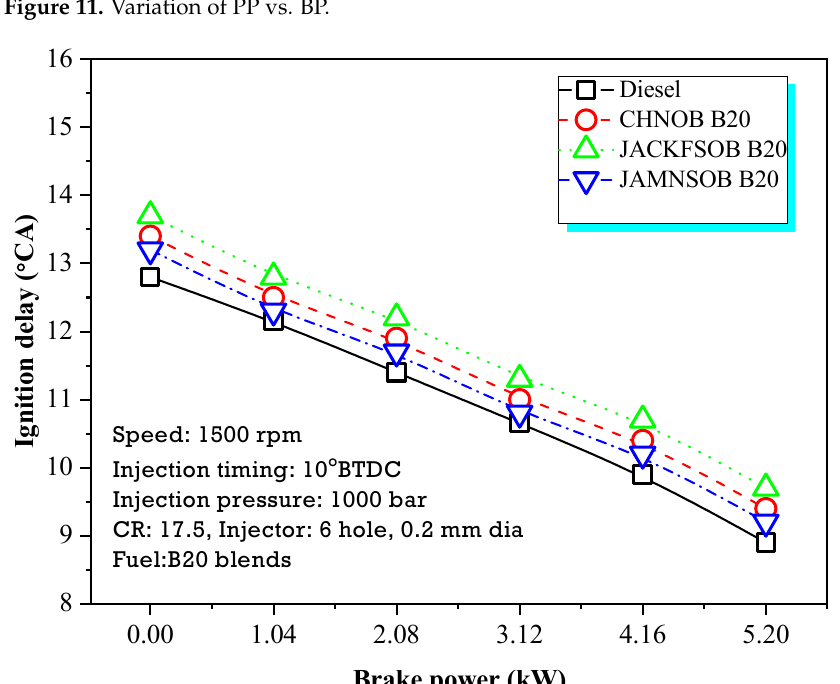
Brake power (kW) Figure 13. Variation of CD vs. BP. CRDI engine fueled with JAMNSOB (B20) exhibited overall good engine character- istics in all aspects.